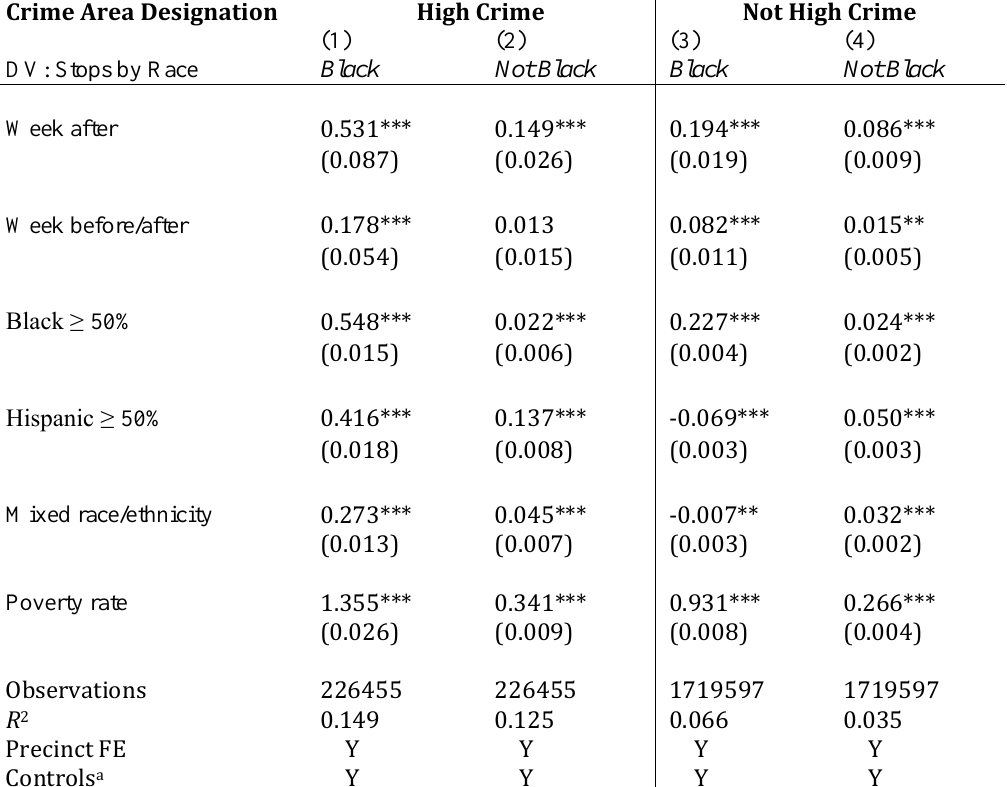
Table 3. Relationship between Local Homicides and Stops, by Race of Resident Stopped and High-Crime Designation